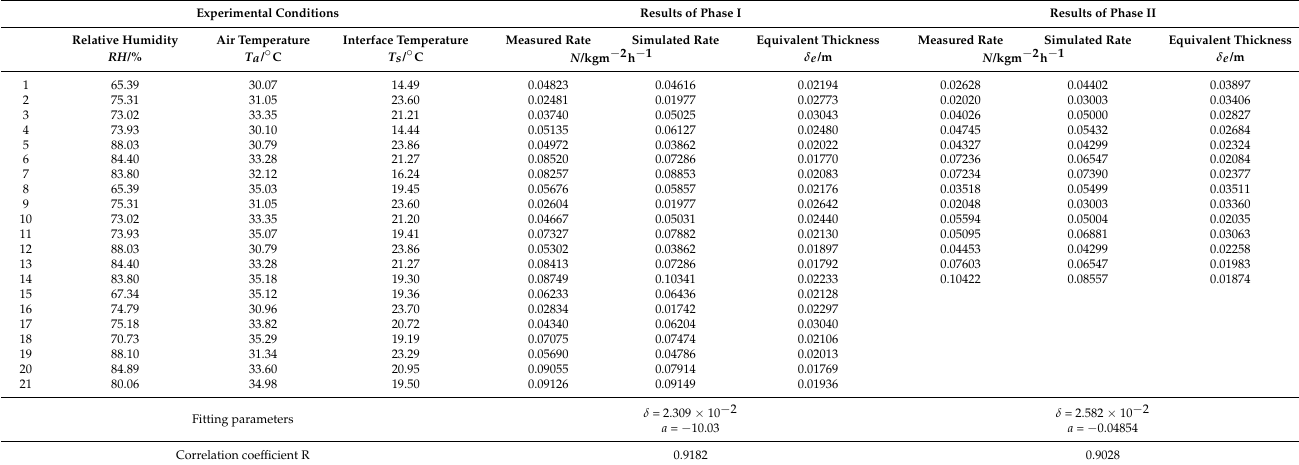
Figure 3. A photograph ( left ) and sketch ( right ) of the laboratory setup [16]. The desiccator (c) is placed in an electron oven. The soil sample (a) is kept in a culture dish and cooled down using a sandwich beaker and circulating water (b). The vapor pressure in the desiccator is controlled by the oven temperature and a saturated salt solution (d). Table 1. Data from published laboratory experiments [16] and simulations using the proposed model. R values of simulations using the proposed model were >0.9 and fitting parameters are given. Optimized thicknesses of the equivalent air layers δ e were also listed.